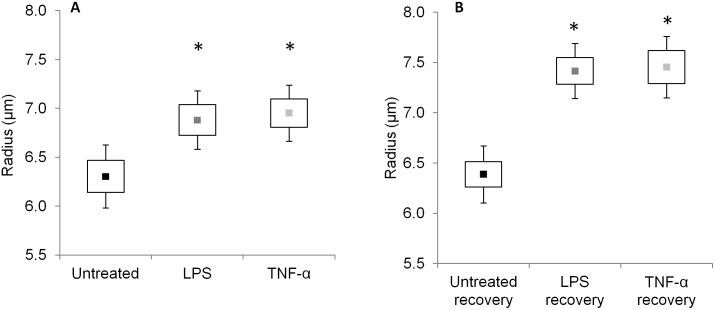
Cell radius measured at 333 mOsm/L at (A) 24 hour and (B) 7-day recovery time points.Data shown is mean (▪), standard error (boxes), and 95% confidence intervals (whiskers; n = 52–127 cells per group). *p<0.03 vs. untreated or untreated recovery control.